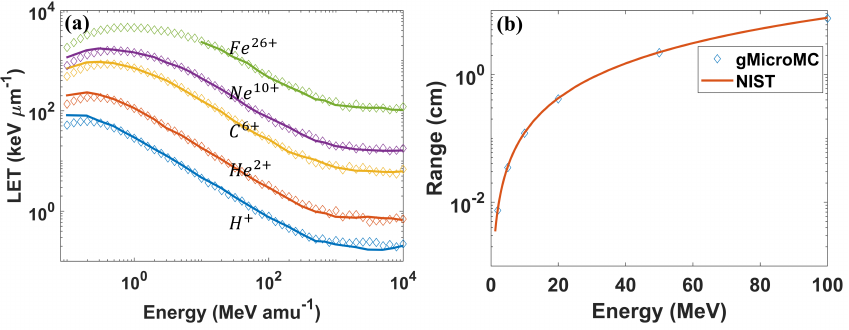
Figure 2. ( a ) The unrestricted LETs for different ions with different energies. The unit amu − 1 means per nucleon. Solid lines represent data extracted from Plante et al.’s work, while data with diamond symbols are from our simulation with gMicroMC. ( b ) The simulated proton range for different